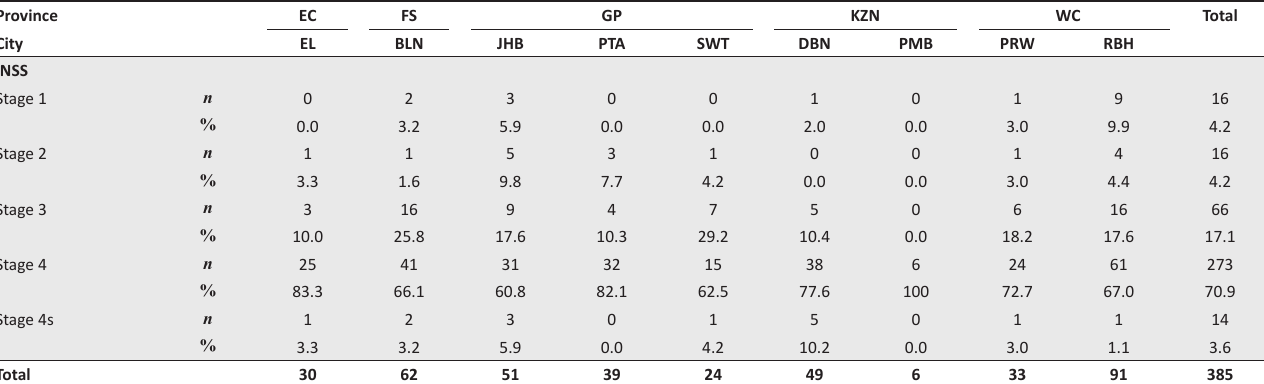
TABLE 4: Neuroblastoma staging at diagnosis from 2000 to 2014 in South